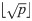
Error rate estimates for the real data null case study without correlations.Shown are different error rate estimates for studies based on six real data sets with uncorrelated predictors and two or three response classes, respectively, of nearly the same size. The error rate was estimated through the test error, the OOB error, the stratified OOB error, the CV error, and the stratified CV error for settings with different sample sizes, n, and numbers of predictors, p. The mean error rate over 1000 repetitions was obtained for a range of mtry values. The vertical grey dashed line in each plot indicates the most commonly used default choice for mtry in classification tasks, that is ⌊p⌋.